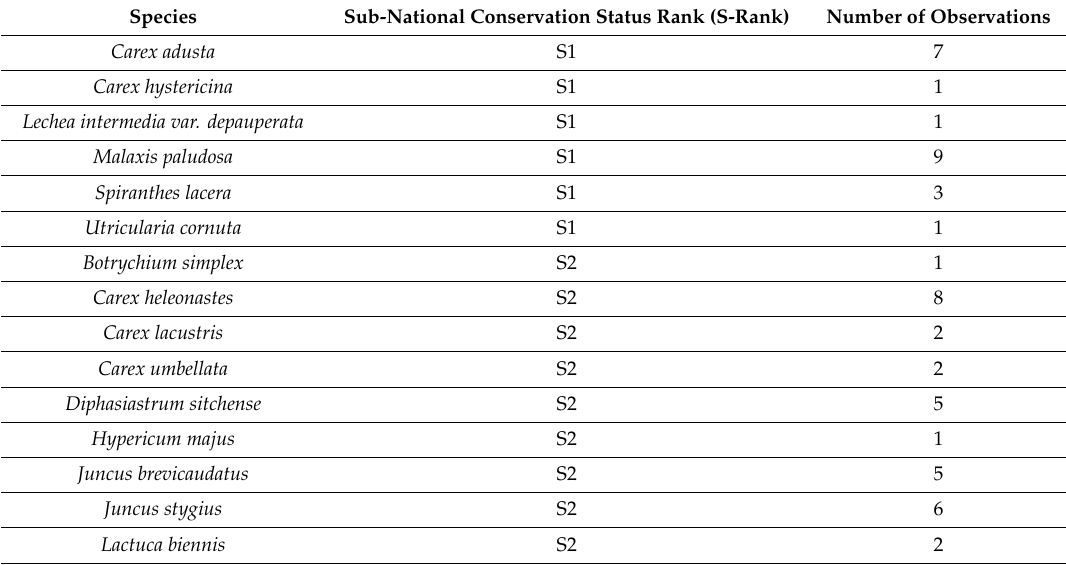
Table A1. Rare (S1 and S2-ranked) vascular plant species encountered across 602 field plots (0.25 ha) in northeastern Alberta, Canada. Rare species were encountered at 54 sites. The number of plots where each species was detected is reported along with the species conservation status rank as of